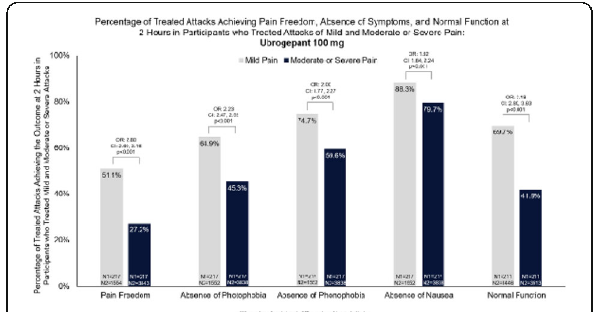
Fig. 2 (abstract P0382). See text for